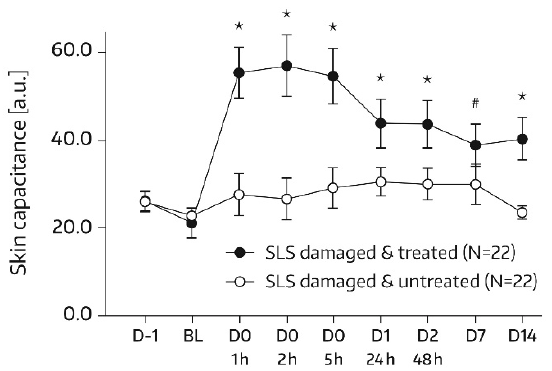
Figure 6. Results from skin capacitance measurements in untreated SLS-damaged skin and SLS- damaged skin undergoing a single application of Emollient 2 (first 48 h) followed by once-daily application for 12 days. The values were assessed by corneometry and are presented as mean ± SD. SLS challenge started on day -1 and ceased 24 h later (30 min before BL assessment). BL = Baseline skin capacitance value before first product application; D = day; h = hour; SLS = sodium lauryl sulfate. * p < 0.001 if compared to untreated control, paired t -test; # p = 0.016 if compared to untreated control, paired t -test.